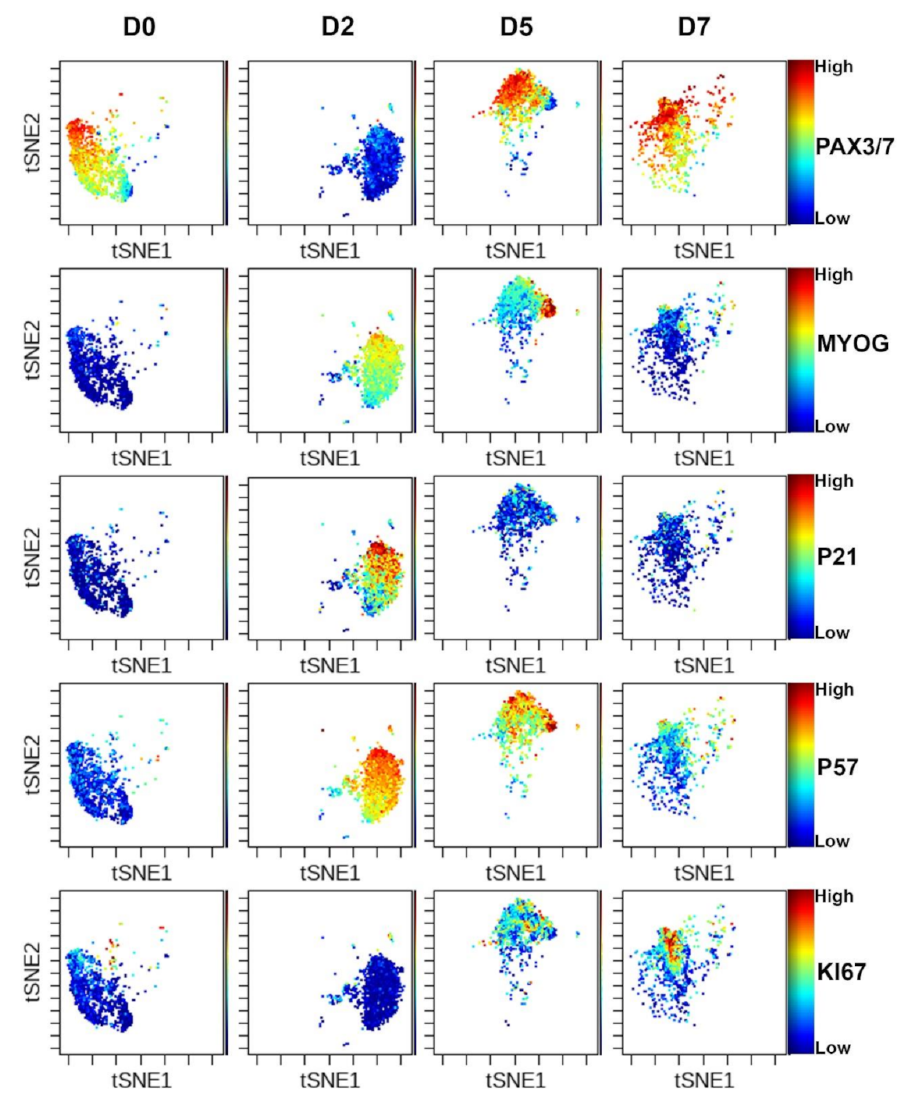
Figure 3. Cyclic activation of muscle stem cells during injury. viSNE analysis of GFP+ cells at each time point with several markers shown. Low expression-blue, high expression